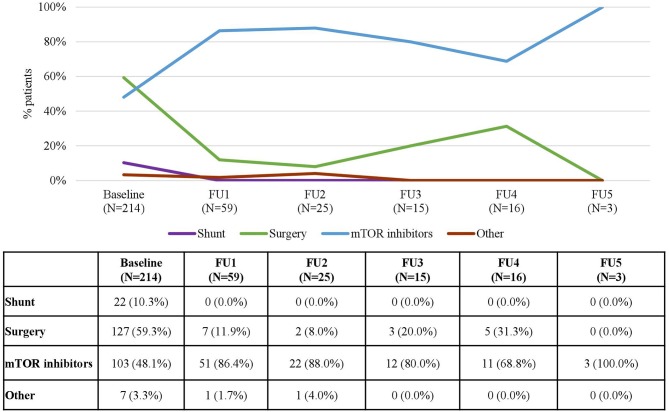
Treatments for SEGA in each Follow-up Visit. Patients may receive more than one treatment. Baseline data refers to patients who “ever had” the manifestation.